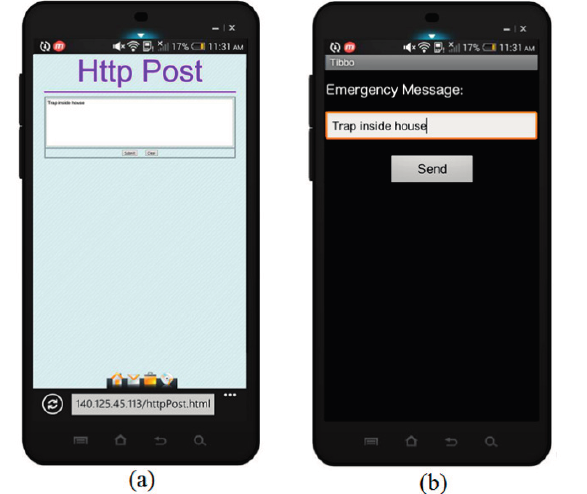
Figure 8. Emergency message interface: ( a ) web interface; ( b ) Android